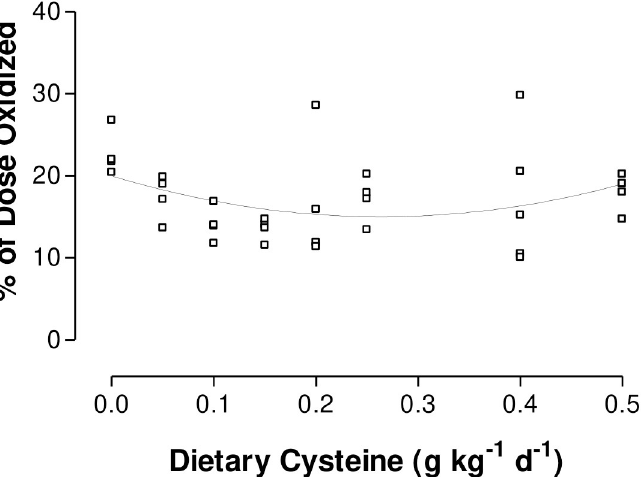
Fig 2. Oxidation of L-[1- 14 C]Cys as a percentage of dose in enterally fed piglets receiving graded levels of Cys and 0.25 g kg -1 d -1 Met. Cys oxidation was associated with Cys intake in a second order polynomial response (y = 20.09– 27.79x + 71.70x 2 ; P < 0.05, R 2 = 0.12) with Cys oxidation minimized at 0.25 g Cys kg -1 d -1 .